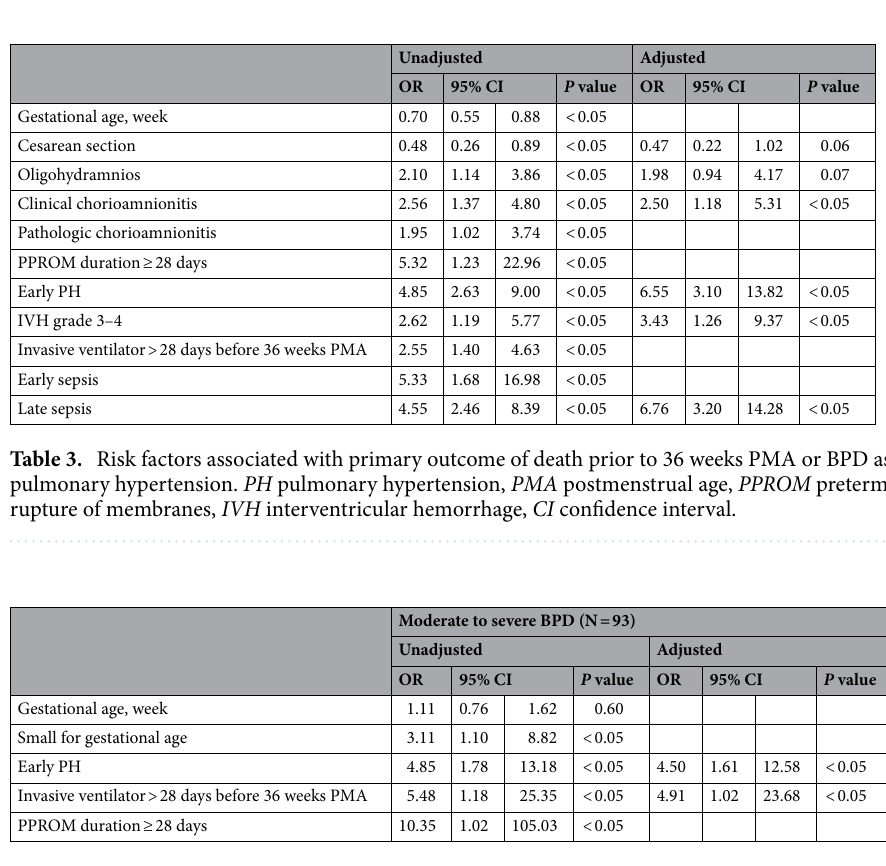
Table 4. Risk factors associated with late PH among moderate to severe BPD patients. PH pulmonary hypertension, m/s BPD moderate to severe bronchopulmonary dysplasia, PMA postmenstrual age, PPROM preterm premature rupture of membranes, CI confidence